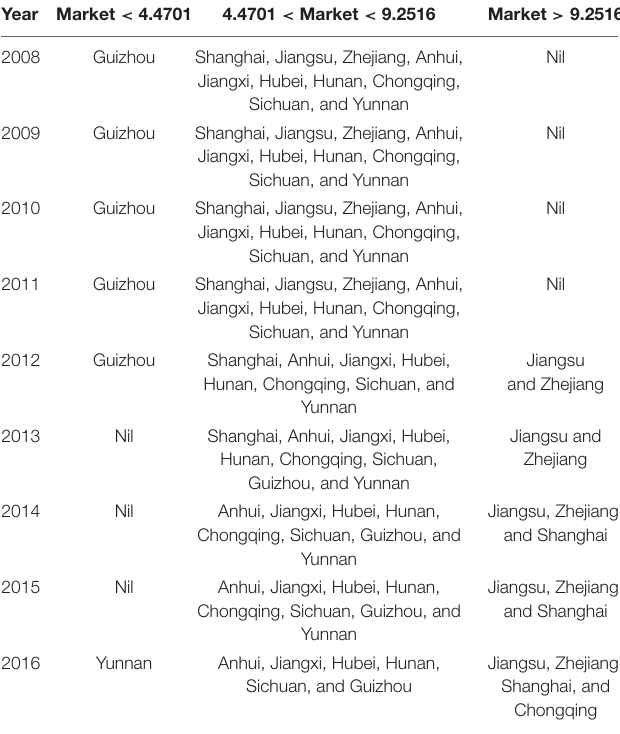
TABLE 5 | Statuses of how the marketization levels of the 11 provinces and cities in the Yangtze River Economic Belt crossed the threshold, 2008–2016. Year Market <